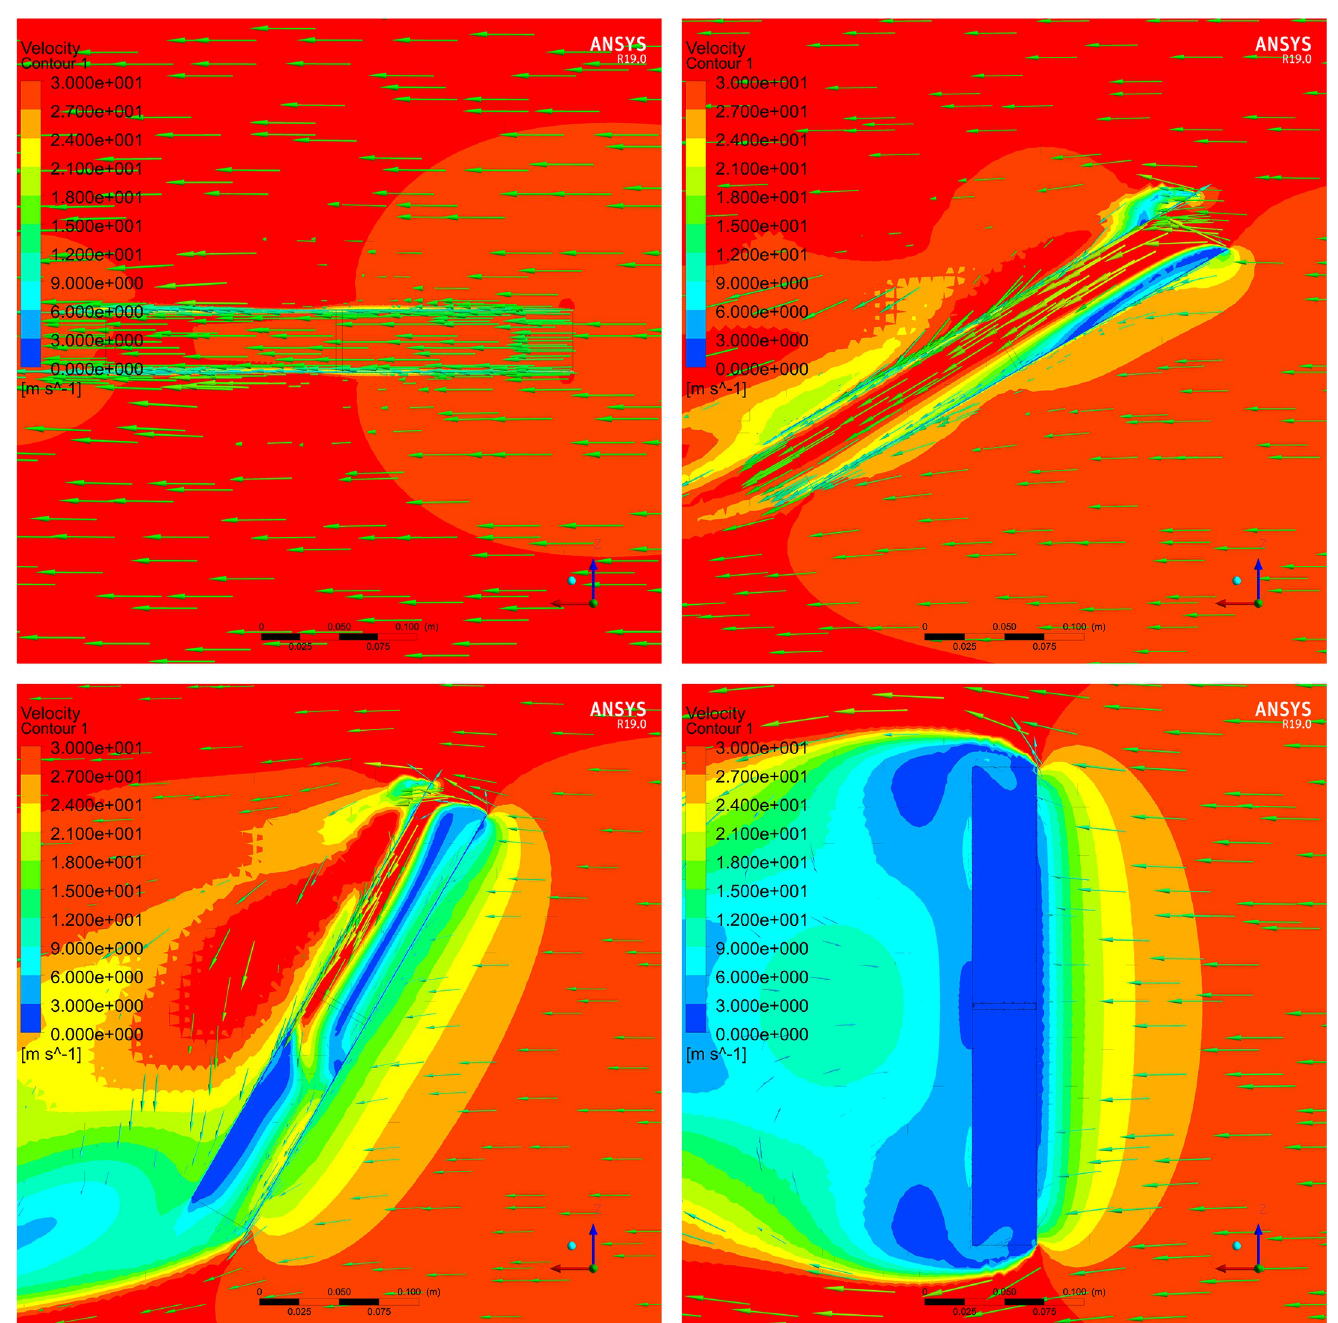
Fig 6. Airflow distribution of the central plane for different angles between the airflow tunnel and external wind vector. Results for angles of (A) 0˚, (B) 30˚, (C) 60˚, and (D) 90˚ between the airflow tunnel and external wind vector.